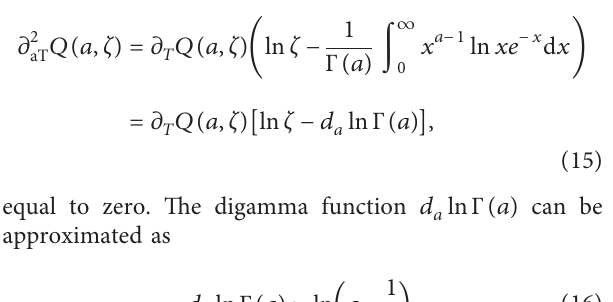
Q ( a, ζ ) , and z 2 T